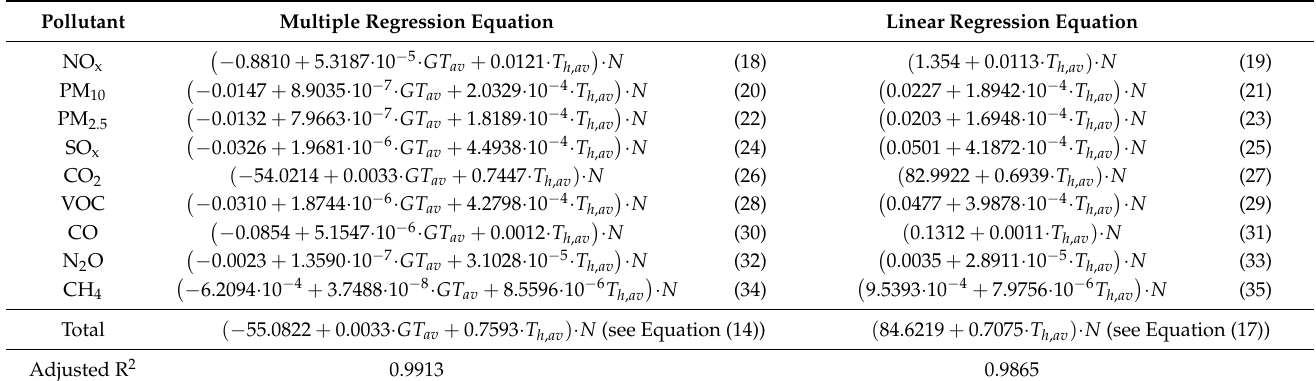
Table 19. Regression equations’ summary proposed by pollutant to calculate emissions from average value GT ( GT av ), average value T h ( T h,av ) and number of ships ( N ).